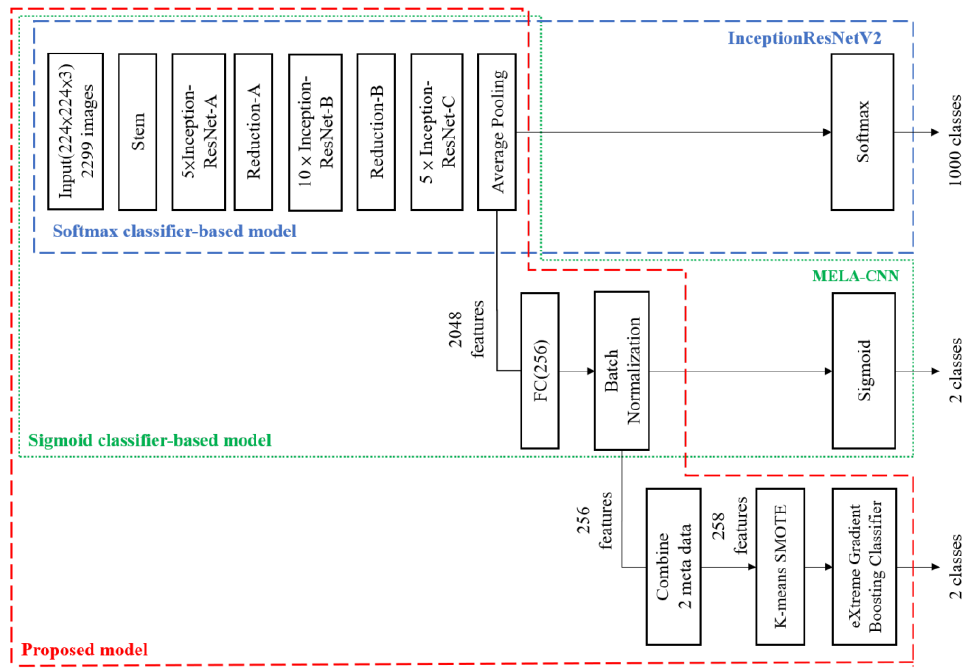
Figure 3. Proposed model architecture.